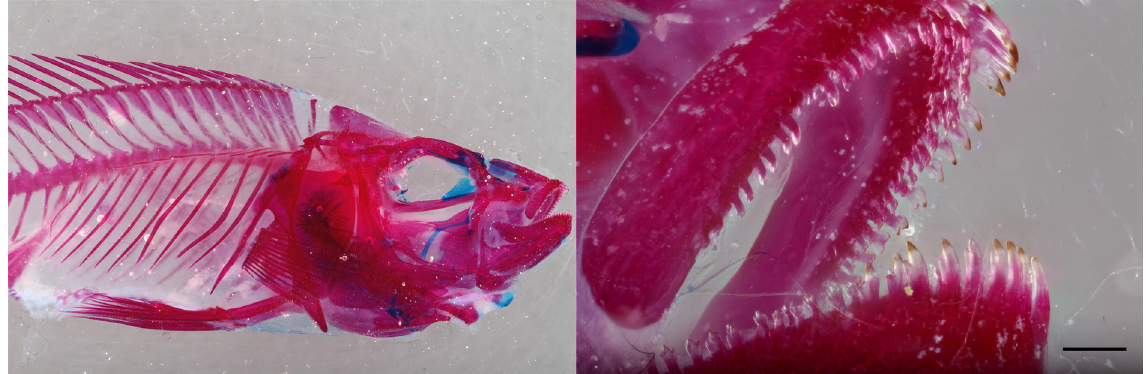
Fig. 2.11. Specimen stored within glycerin. Cleared and stained specimen of Haplochromis sp . pictured in glycerin. The right part of the picture is photographed with a magnification of 5×. Scale = 500